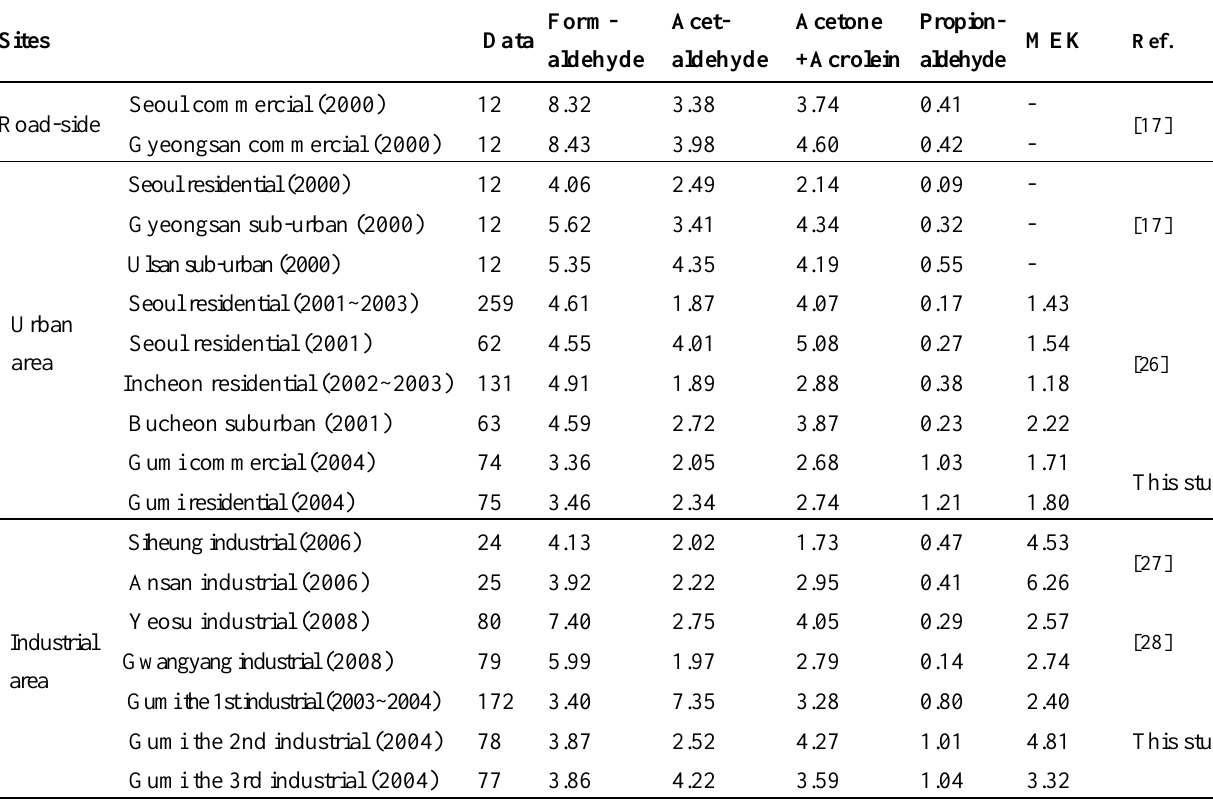
Table 6. Ambient concentrations (ppb) of carbonyl compounds in urban and industrial areas in Korea. Sites Data